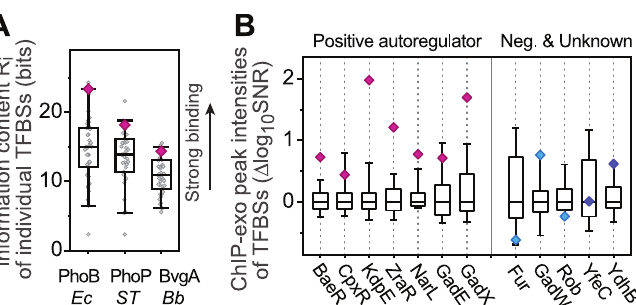
Fig 4. Positively autoregulated TFs have strong affinities for their own promoters relative to their other binding sites. (A) Distribution of individual information content ( R ) of TFBSs. R of every TFBS (gray circles) was analyzed for i i PhoB from E . coli , PhoP from Salmonella enterica Ser. Typhimurium, and BvgA from Bordetella bronchiseptica . Values for TFBSs within the positively autoregulated promoters are shown as magenta diamonds. The numbers of TFBSs are: PhoB, 28; PhoP, 39, BvgA, 47. (B) Binding strengths of individual TFBSs reflected by ChIP-exo peak intensities. Logarithmic values of ChIP peak intensities (SNR) after subtracting the median ( Δ log 10 SNR) are shown as box plots. Binding peaks within the promoter of the operon encoding the TF are highlighted in color by their positive (magenta), negative (cyan) and unknown (blue) roles in autoregulation. The numbers of ChIP peaks for each TF are: BaeR, 178; CpxR, 113; KdpE, 78; ZraR, 107; NarL, 81; GadE, 35; GadX, 43; Fur, 66; GadW, 37; Rob, 534; YfeC, 50; YdhB, 29. Whiskers in all box plots indicate the range of